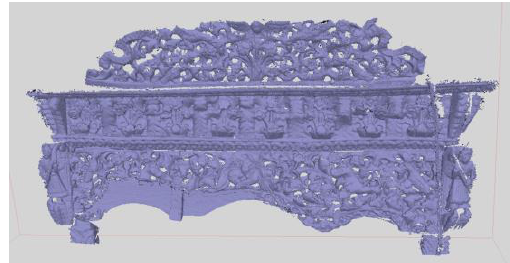
Fig. 4a Polygonal surface derived from the SfM procedure